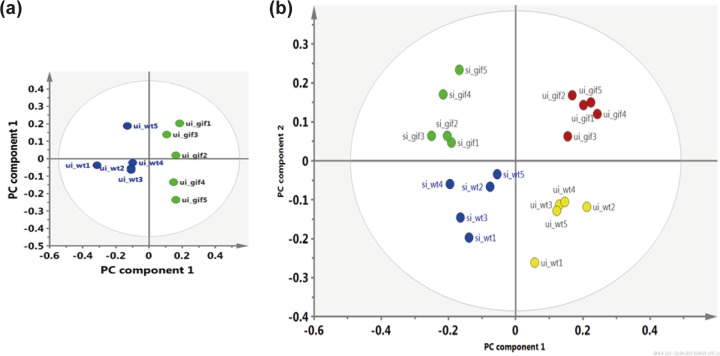
Metabotyping of blood serum from F2
Giftm1a/tm1a and wild-type mice reveals metabolic abnormalities. (a) PCA score plot separating naive F2
Giftm1a/tm1a mice (green circles) from naive wild-type mice (blue circles) with 92% of the variables explained (R2cum) by using the first four components with 72% predictability minus Q2. (b) Multivariate data analysis results comparing the blood serum of uninfected F2
Giftm1a/tm1a (ui_gif; red circles) and wild-type (ui_wt; yellow circles) mice and that of S. Typhimurium-infected F2
Giftm1a/tm1a (si_gif; green circles) and wild-type (si_wt; blue circles) mice. Principal component 1 discriminates on the basis of the presence or absence of infection, while principal component 2 separates different mouse genotypes, regardless of infection status. Ninety percent of the variables (R2cum) were explained by using the first five components with 73% predictability.